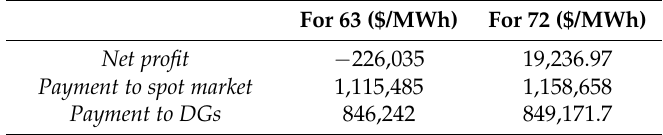
Table 10. Retailer’s profit and costs under different average selling prices in the second